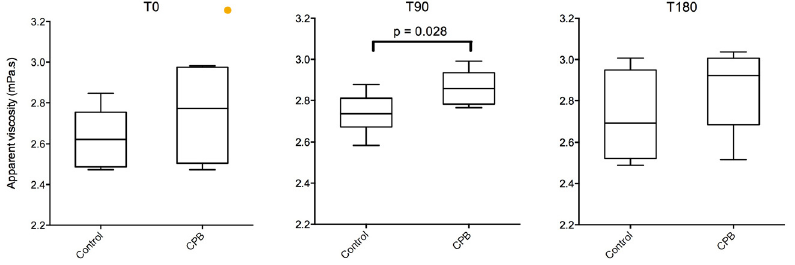
Fig 2. Apparent viscosity of respiratory mucus collected by bronchoscopy in the control and CPB groups at T0 (left panel), T90 (middle panel) and T180 (right panel). Box and whiskers represent the 25th – 75th percentile and minimal – maximal values, respectively. The line in each box represents the